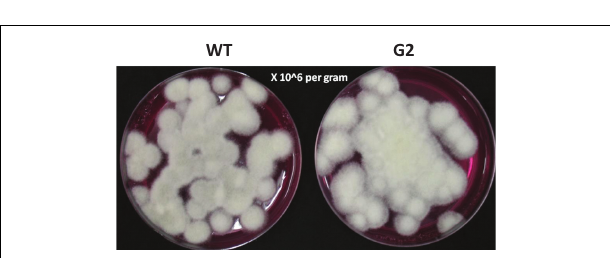
FIGURE 9 | Colony-forming units of Trichoderma virens on PDA-rose bengal medium.